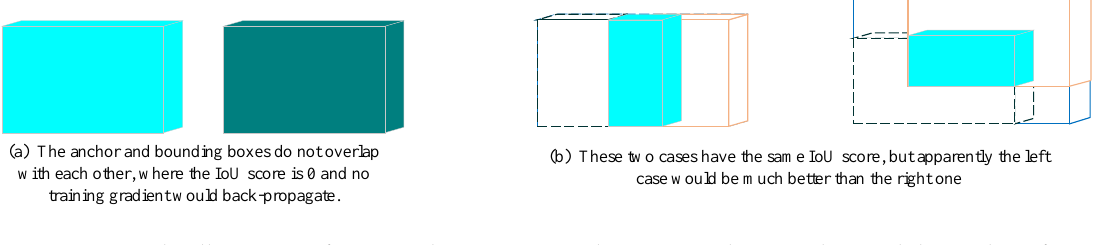
Figure 3. The illustration of non-overlapping case and inconsistcy between loss and the quality of obtained bouding